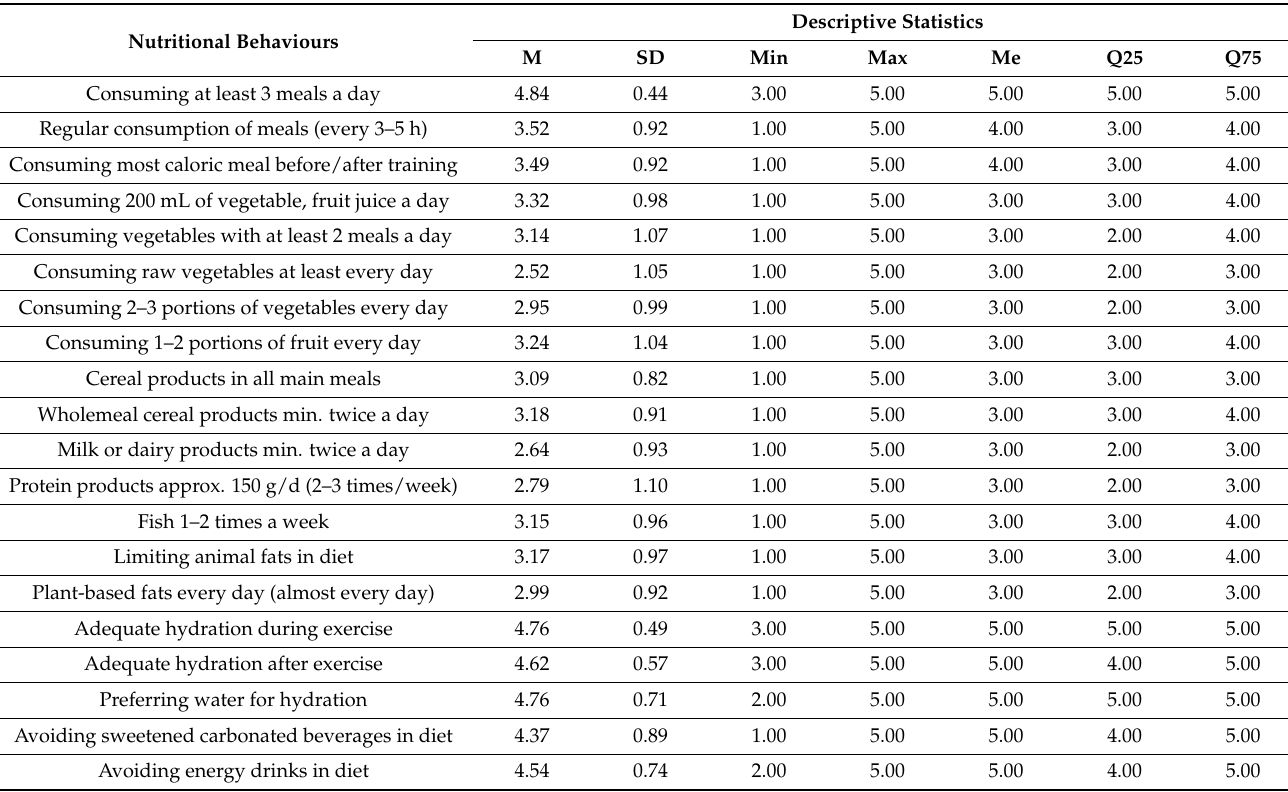
Table 2. Implementing recommendations of the Swiss pyramid and the overall index of proper nutritional behaviours among athletes training in team sports (descriptive